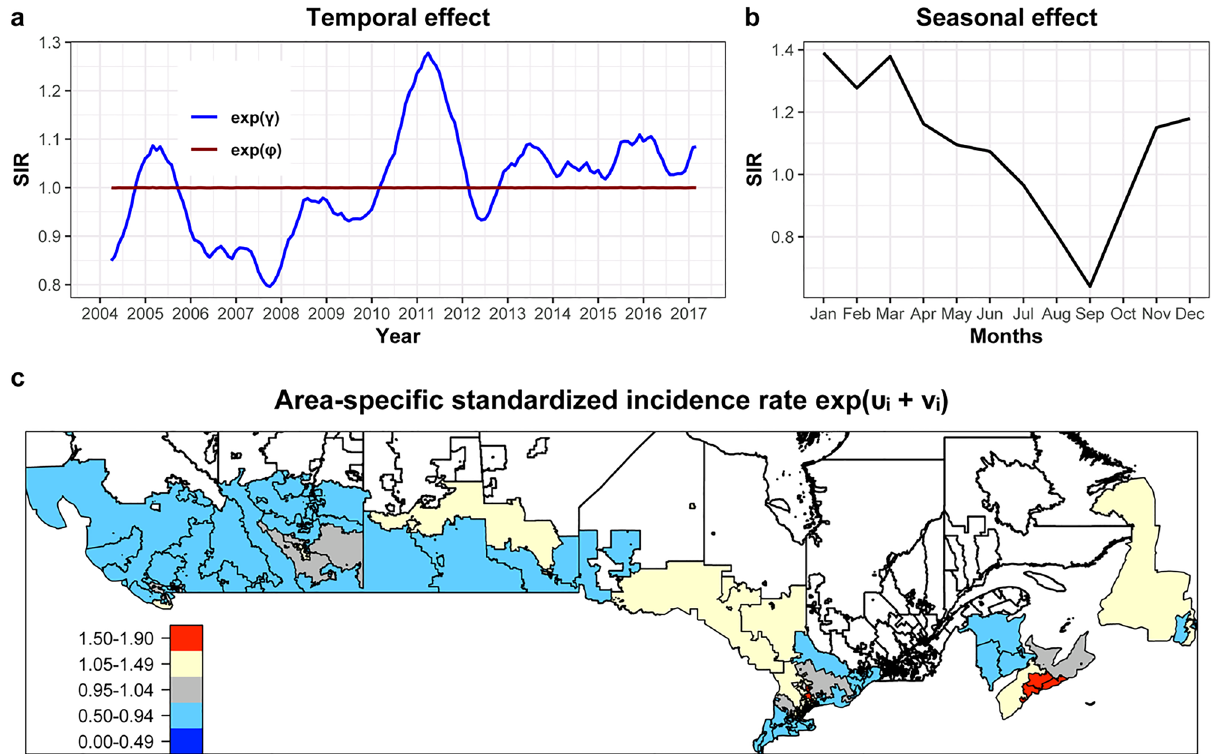
Figure 2. Posterior mean value for the temporal and spatial effects for the risk of Kawasaki disease (KD) in Canada from April 2004 to March 2017 based on the Bayesian hierarchical model. Standardized incidence rate above 1 indicate increased risks, and below 1 decreased risks. ( a ) Monthly temporal unstructured and structured trends. An increasing trend is visible for the unstructured effect (solid line) across time. The structured effect (dashed line) shows nearly no fluctuation. ( b ) The seasonal effect illustrates a below average standardized incidence rate for KD in September and a high risk in the winter months. ( c ) Mean spatially autocorrelated random effect, expressed as area-specific standardized incidence rate. Areas with standardized incidence rate larger than 1 have an above average risk compared to the rest of Canada, while standardized incidence rate smaller than 1 indicate a below average risk. The red colours in the Greater Toronto Area and around Halifax for example indicate a 50 to 90% increase of risk. For better visibility of small regions, an interactive map can be found in the online appendix. The spatial units (of the analysis regions consisting of several forward sorting areas) are indicated with boundaries and grey filling. White regions were added to the plot for easier orientation. For uncertainty estimates, see online